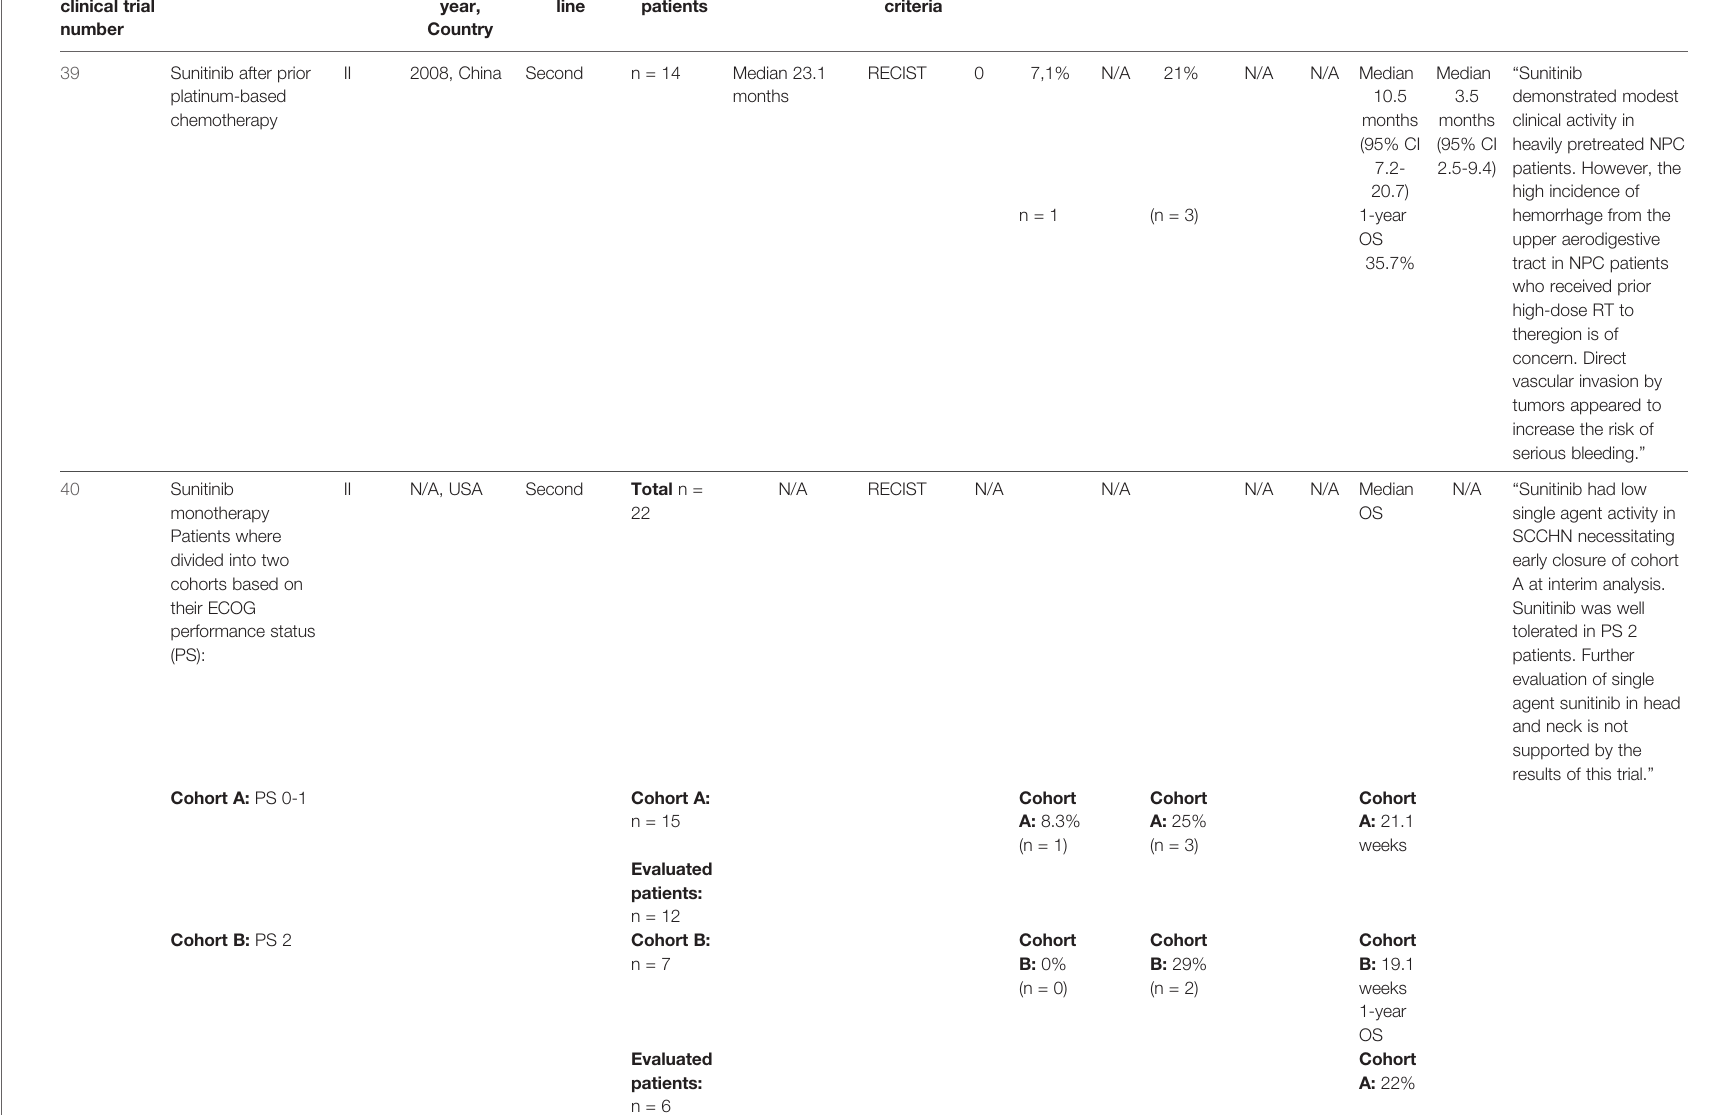
TABLE 3 | Summary of the sunitinib and semaxanib clinical trials for head and neck squamous cell carcinoma. Reference, clinical